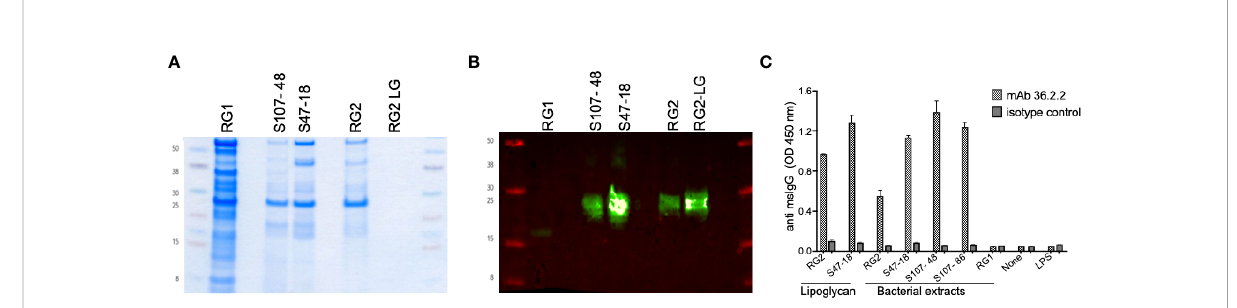
FIGURE 1 Immunoreactivity and binding speci fi city of the murine monoclonal antibody 36.2.2 to the lupus RG strains associated lipoglycan. (A) Coomassie stain for one of duplicate gels loaded equally with the whole extracts of a reference strain (RG1) that lacks the lipoglycan (LG, the two lupus RG strains (S107-48, S47-18) expressing LG, the reference strain (RG2) and LG puri fi ed from this strain (RG2-LG). (B) Immunoblot with the mAb 36.2.2 using the other duplicate gel as in (A) , the blot is showing the reactivity only to the LG band in the two RG lupus strains (S107- 48, S47- 18) as well as the reference strain (RG2) and its puri fi ed LG. (C) Immunoreactivity by ELISA re fl ected as ODs of the mAb 36.2.2 binding to all extracts and to both puri fi ed LGs from RG2 and the lupus strain S47-18 but not the LPS from